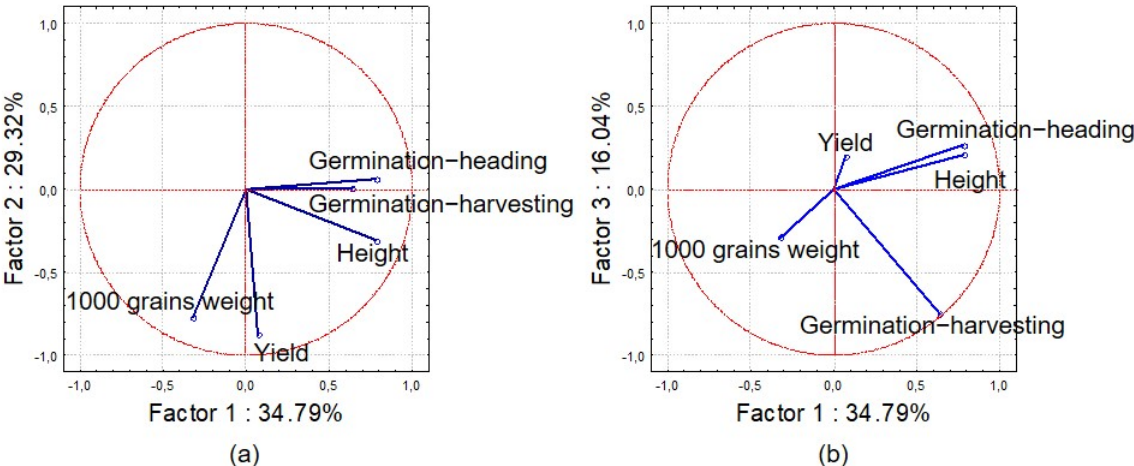
Figure 3. Factor coordinates of the variables: ( a ) Factors 1–2; ( b ) Factors 1–3.